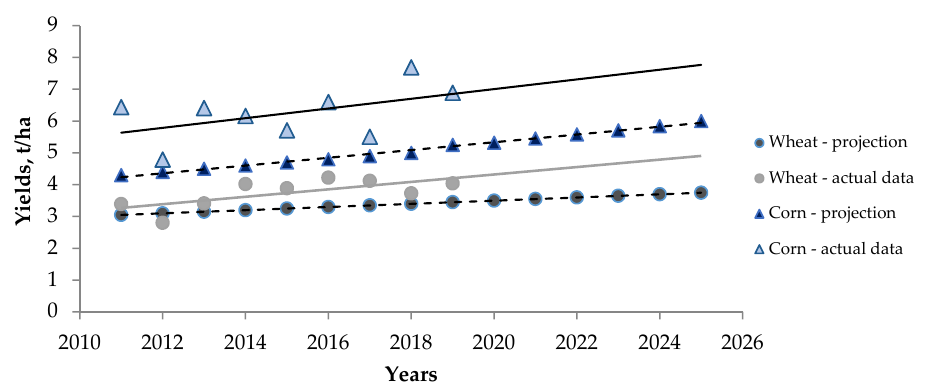
Energies 2020 , 13 , x FOR PEER REVIEW 11 of 23